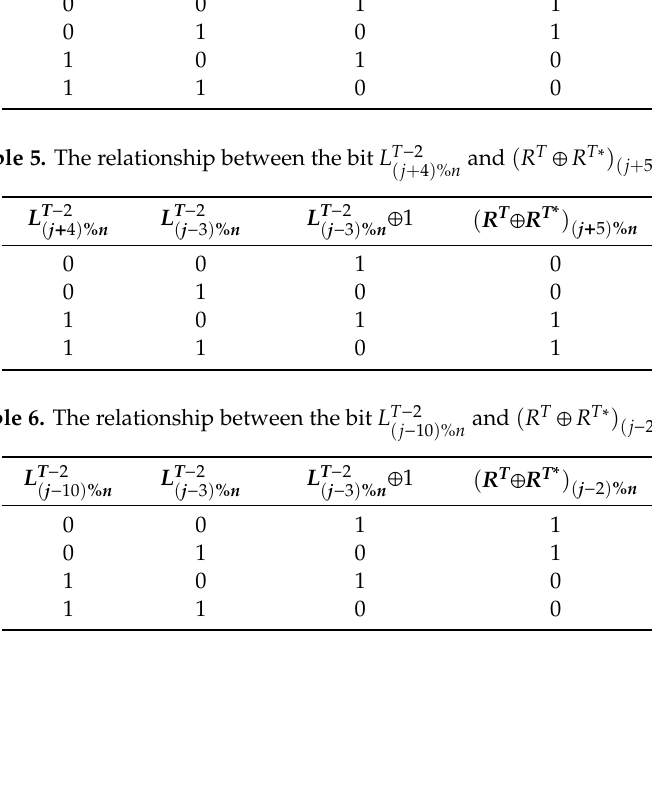
Table 5. The relationship between the bit L T − 2